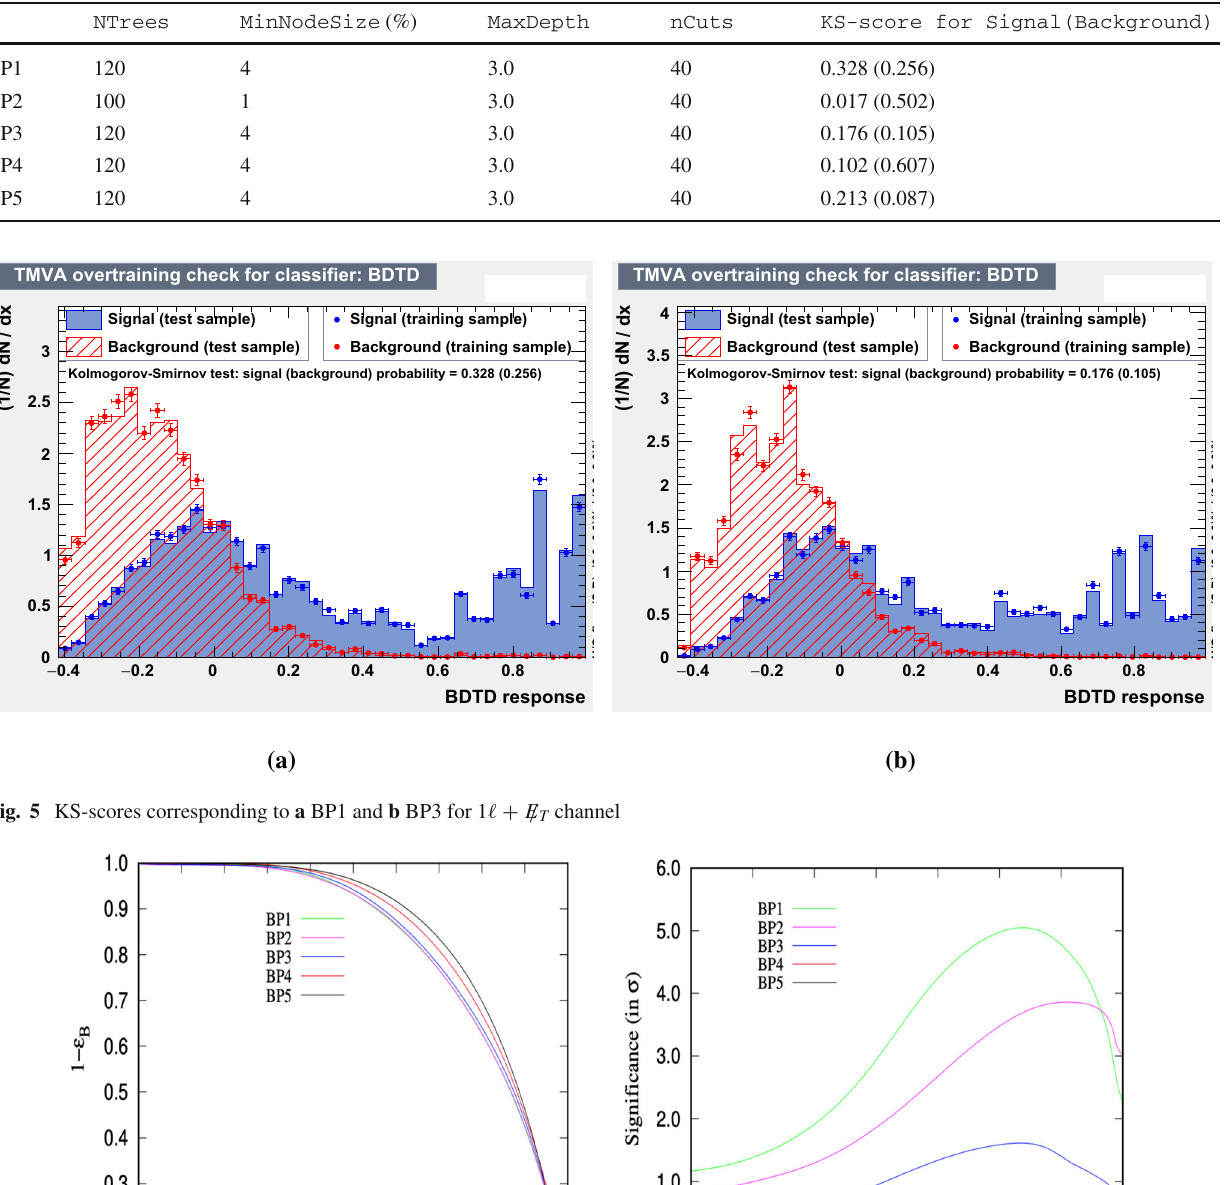
Table 7 Tuned BDT parameters for BP1, BP2, BP3, BP4 and BP5 for the 1 (cid:3) + E T / channel